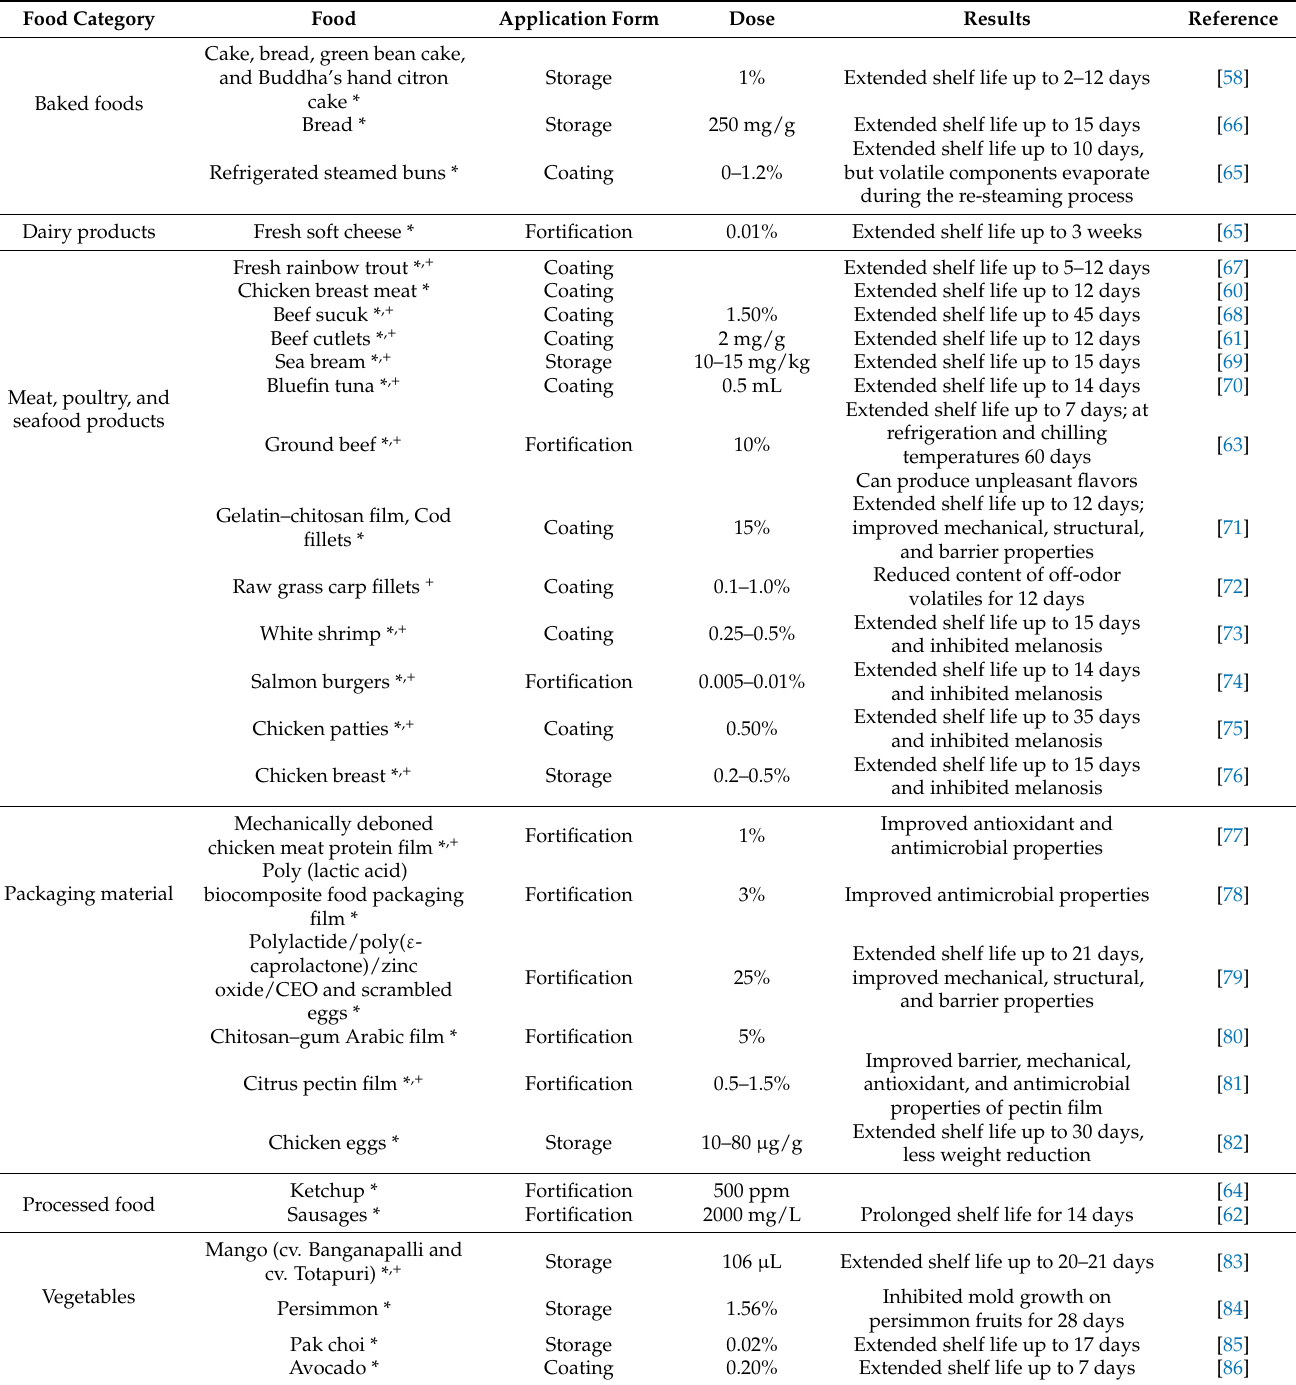
Table 3. Main food applications of